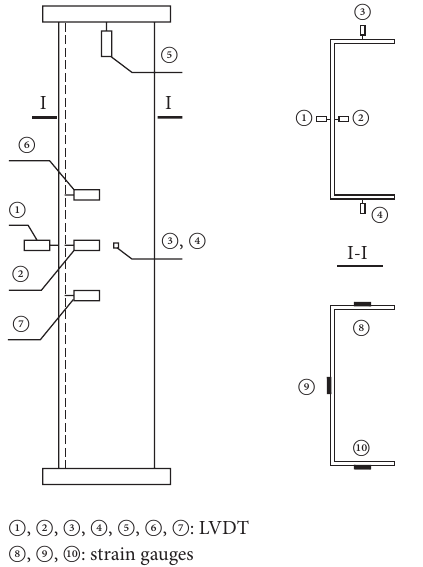
Figure 2: The arrangement of LVDTs and strain gauges.